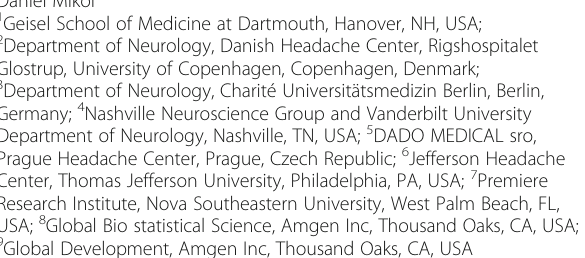
Table 1 (abstract P24). Data on primary and secondary outcomes Safety: Exposure-adjusted Subject Incidence Rates of